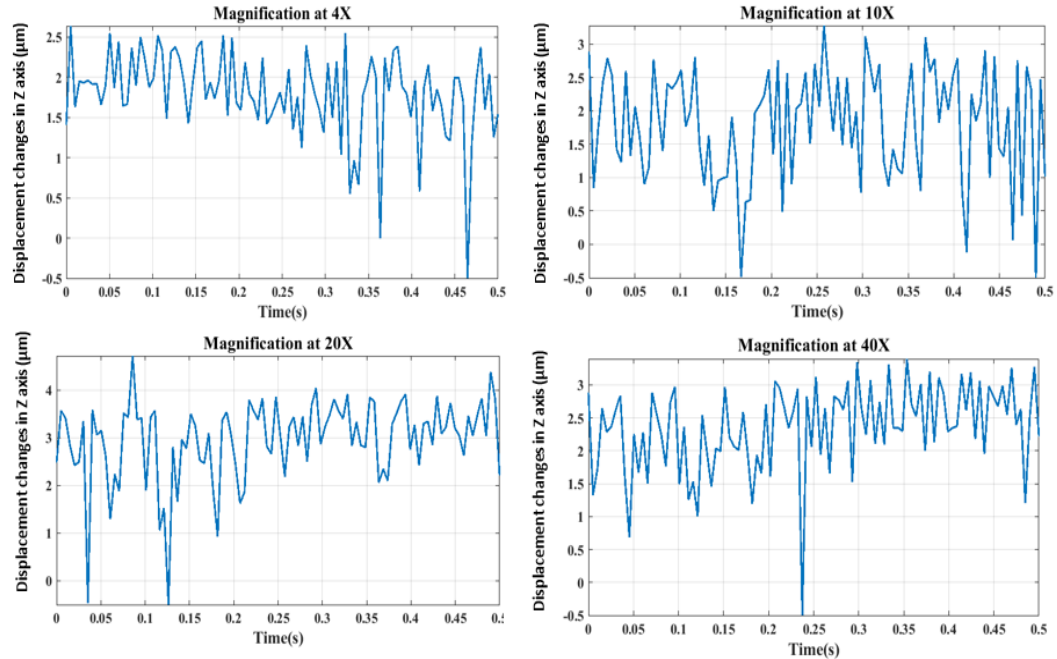
Figure 11. Injection tip position changes in Z-axis using the Brenner gradient method.